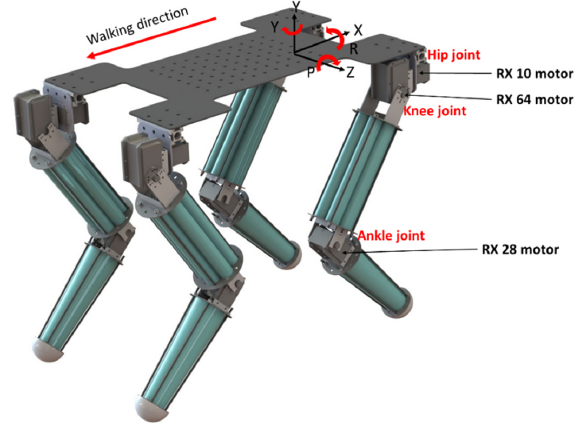
Figure 13. Three-dimensional model of the quadruped robot.